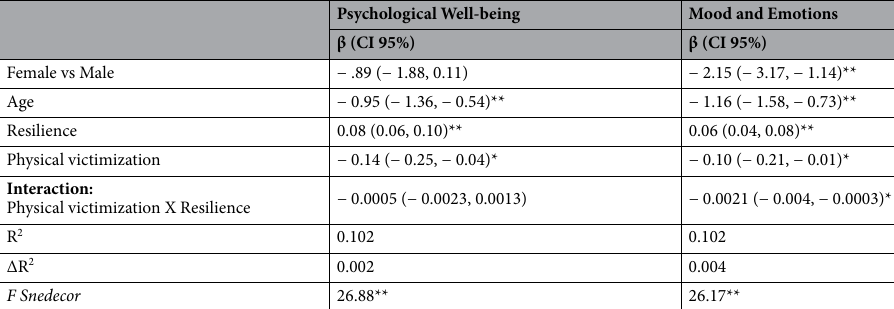
Table 3. Associations between psychological domains of HRQoL and resilience among adolescents exposed to physical victimization. Associations between physical victimization and resilience on psychological domains calculated by linear regression analyses expressed through β coefficients and 95% confidence intervals (CI 95%). * p < 0.05; ** p < 0.001.